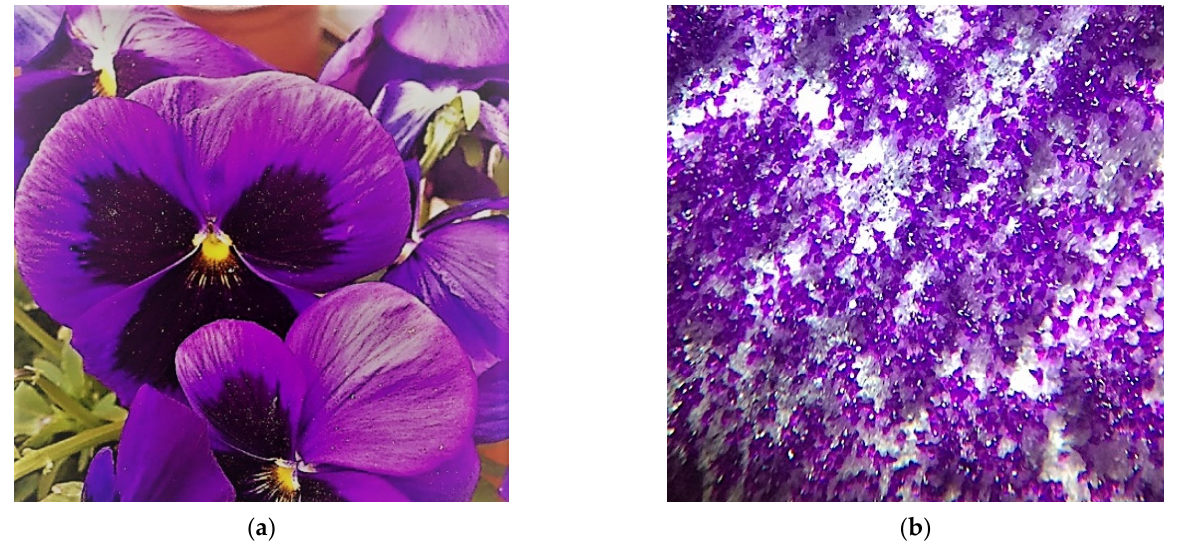
Figure 1. Garden pansy (Viola x wittrockiana) . ( a ) Photo of the crown petals of a garden pansy flower. ( b ) Image of the flower petal surface taken from a 3D microscope Zeiss Stemi DV4, magnification 32 times.